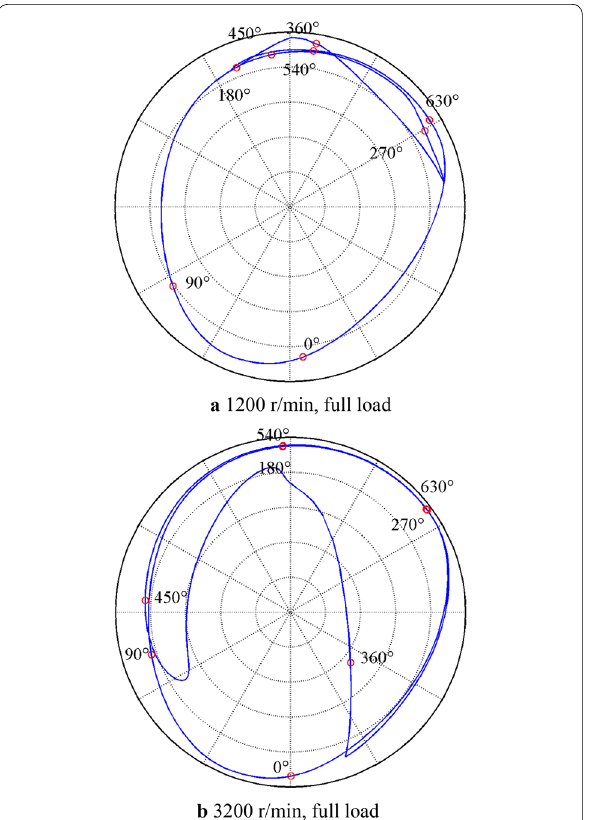
Figure 5 Journal axis orbit of connecting-rod